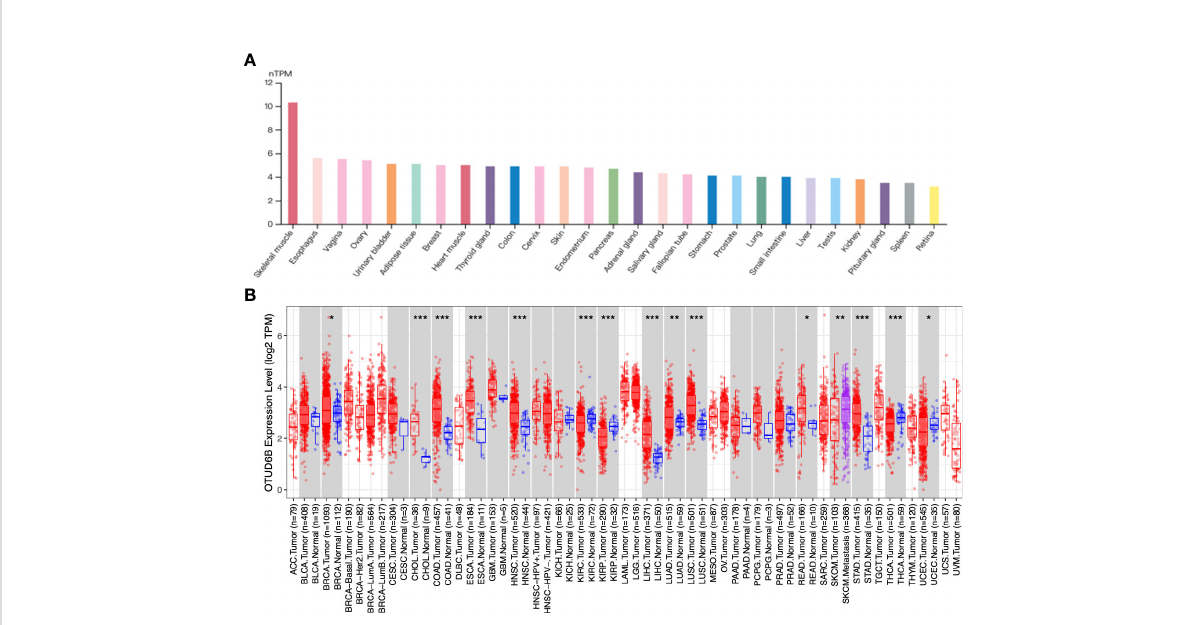
FIGURE 1 OTUD6B expression in various tissues and tumors. (A) The level of OTUD6B in different normal tissues from the HPA database. (B) The expression differences of OTUD6B between normal and tumor tissues from the TIMER database. (*p < 0.05; **p < 0.01; ***p <